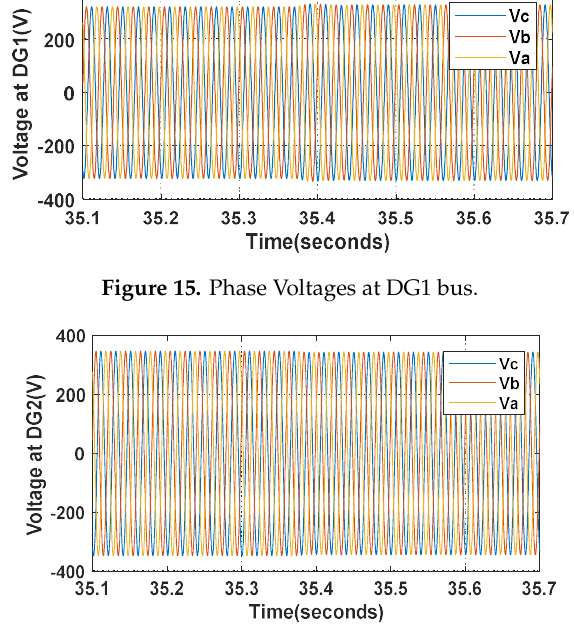
Figure 16. Phase voltages at DG2 bus.